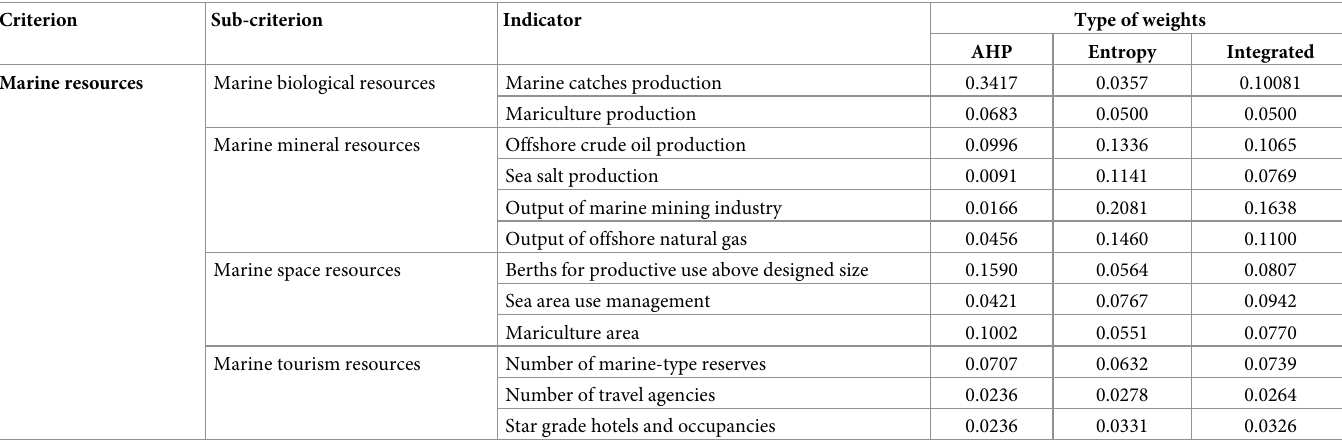
Table 1. Index system for the input of marine